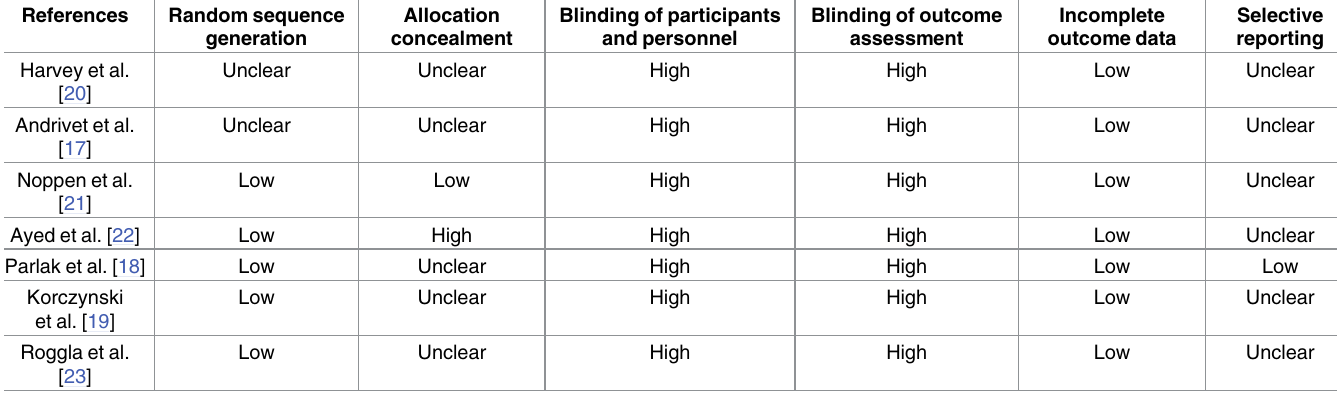
Table 2. Risk of bias